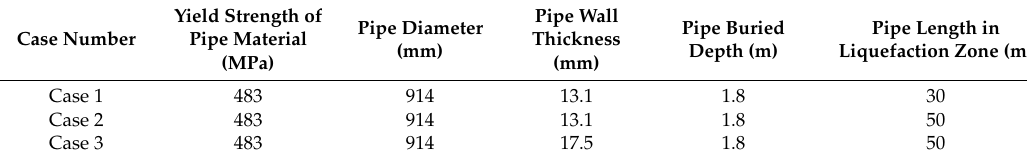
Table 1. Engineering parameters for the three different cases.